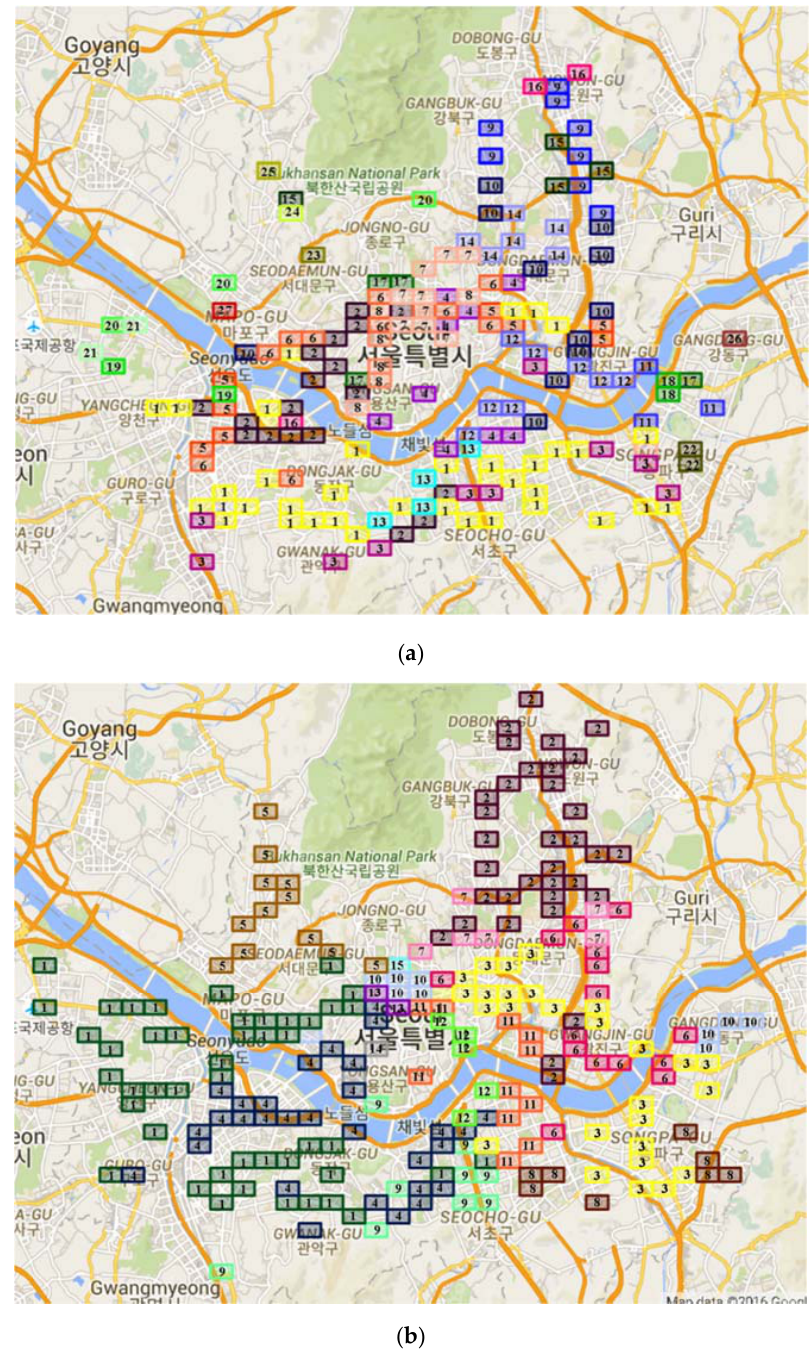
Figure 5. Clusters of HIRs in Seoul. ( a ) Morning commute HIR; ( b ) Evening commute HIR. Their hierarchical clustering progress can be seen in Appendix A.